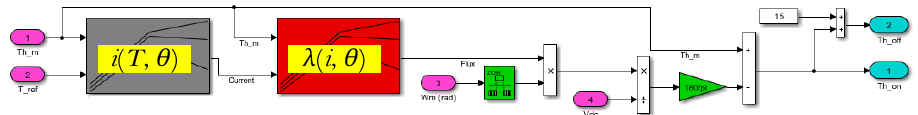
Figure 16. The simulation implementation of turn on and turn off angles of improved DITC of [28].